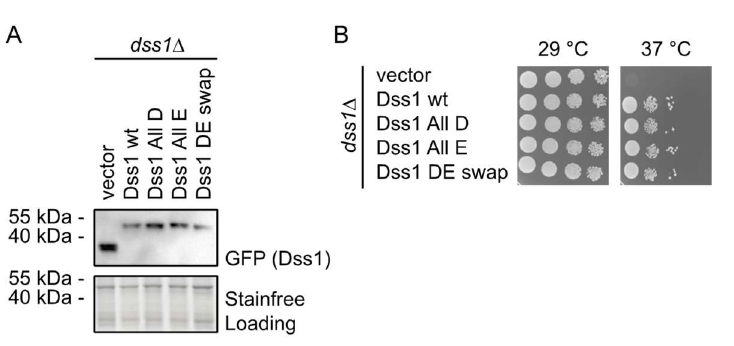
Figure 3. Growth effects of Asp and Glu substitutions in Dss1. ( A ) S. pombe cells deleted for Dss1 ( dss1 ∆ ) were transformed to express GFP-tagged wildtype (wt) Dss1 and the indicated Dss1 variants. Whole-cell lysates were then compared via SDS-PAGE and Western blotting using antibodies to GFP. Stain-free labeling was used as a loading control. ( B ) The growth of the strains from ( A ) was compared by serial dilution and incubation on solid media at 29 ◦ C and 37 ◦ C. Note that the temperature-sensitive growth defect of the dss1 Δ strain is rescued by all Dss1 variants.